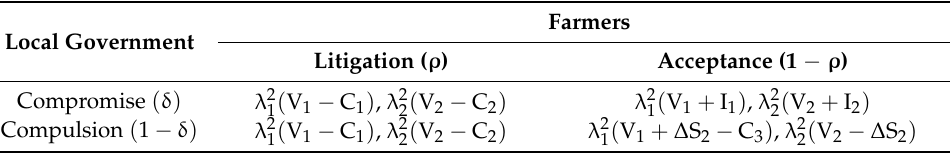
Table 1. Game payment matrix under litigation